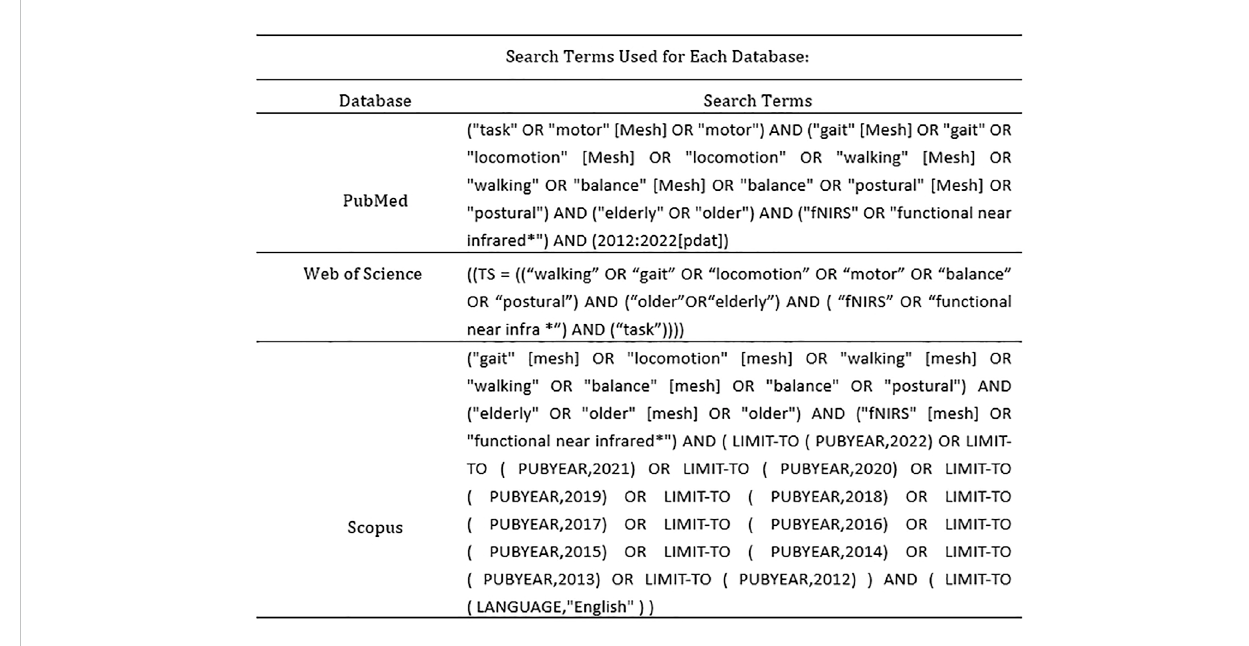
FIGURE 1 Search string key terms used for study acquisition.